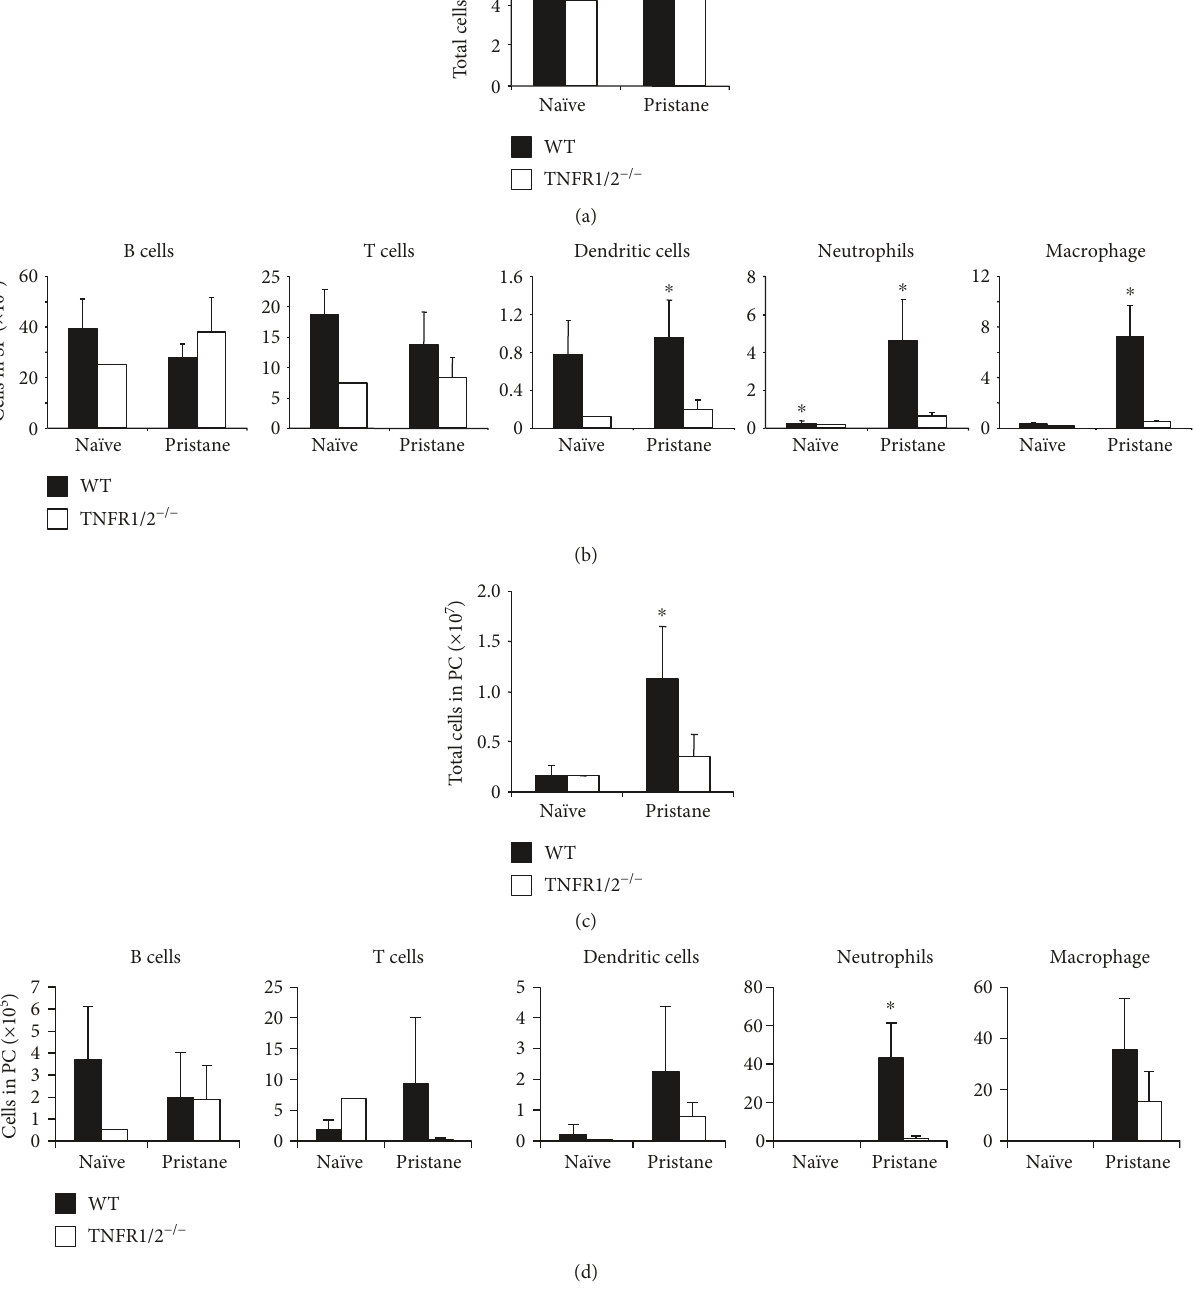
Figure 5: The absence of TNFR1/2 inhibited the recruitment of splenic neutrophils, macrophages, and dendritic cells in response to pristane treatment. (a, b) TNFR1/2 − / − mice and WT mice were injected with 300 μ L (8.3 × 10 − 4 mol) of pristane and sacri fi ced at three weeks thereafter. Total number of cells and the number of each cell type were calculated. (c, d) Total number of cells and the number of each cell type in the PC were also analyzed. The di ff erence between WT and TNFR1/2 − / − mice is shown. Data represent two independent experiments. ∗ p < 0 05